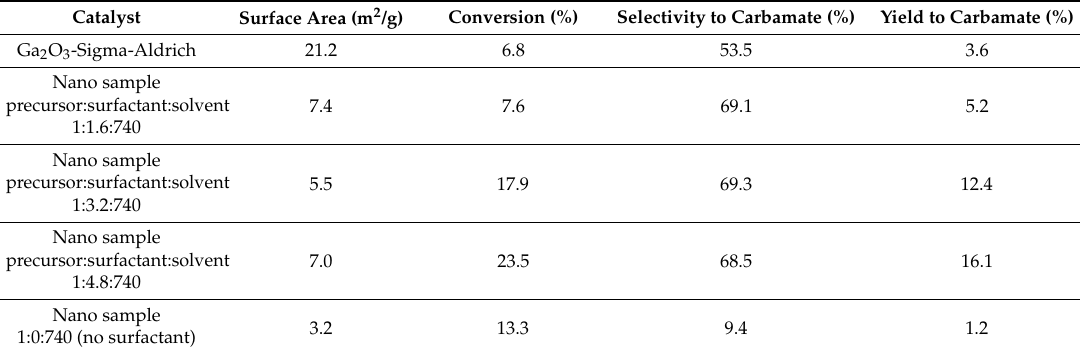
Table 3. Catalytic performance and BET surface areas of the Ga 2 O 3 nano samples used for the synthesis of propyl N-octylcarbamate from n-octylamine, CO 2 and